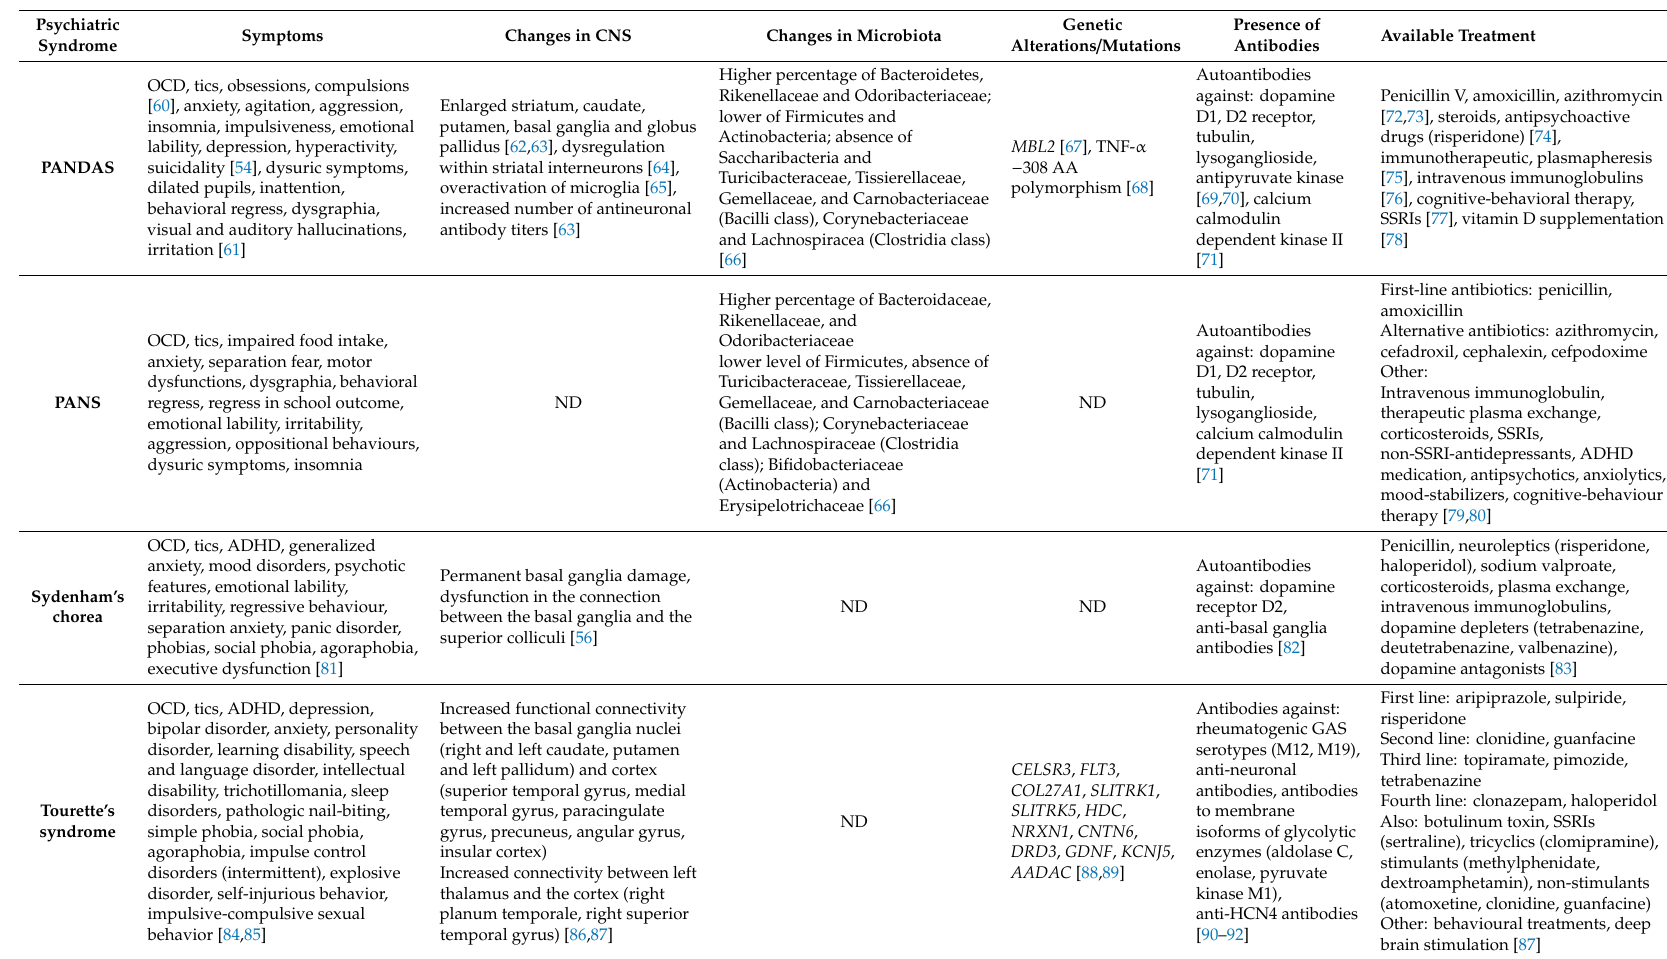
Table 1. Characteristics of Pediatric Autoimmune Neuropsychiatric Disorders Associated with Streptococcal Infections (PANDAS), Pediatric Acute-Onset Neuropsychiatric Syndrome (PANS), Sydenham’s chorea, and Tourette